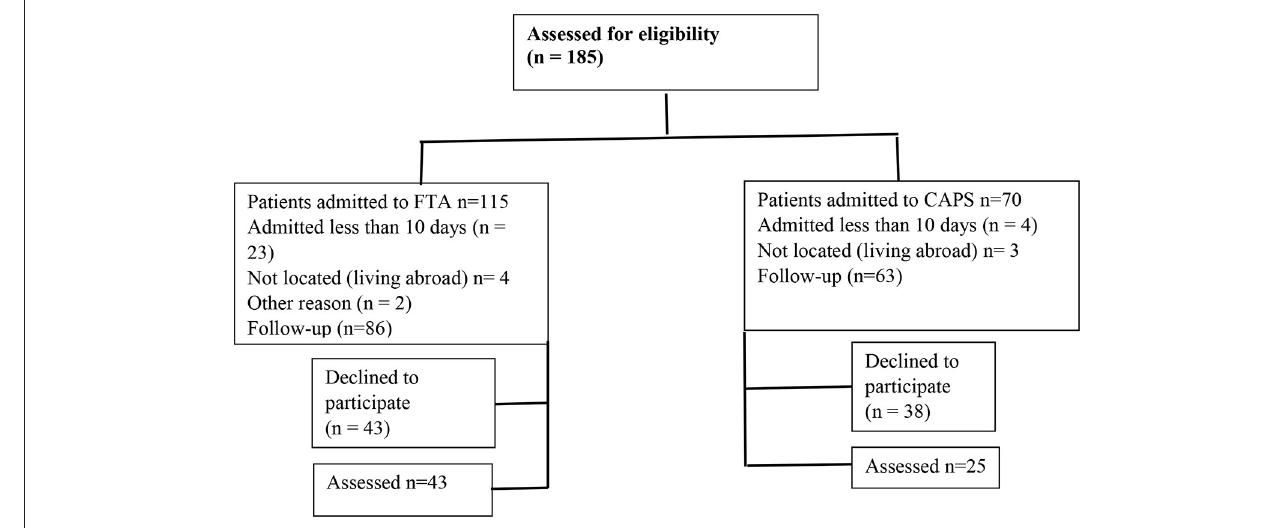
FIGURE 1 | Flowchart.